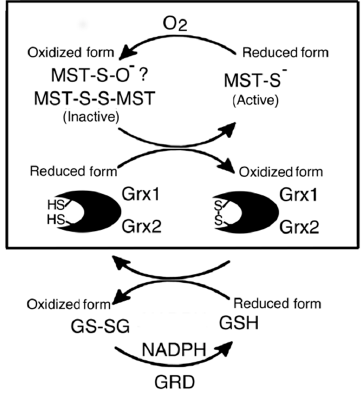
Figure 6. Probable activation mechanism of MST in the Grx-GSH-GRD-NADPH reducing systems.